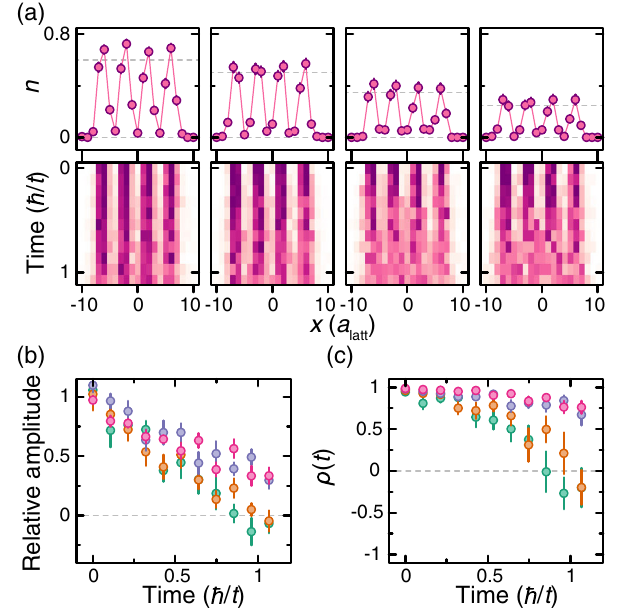
FIG. 5. Density dependence of quench dynamics. (a) (Top) initial state density profiles; (bottom) corresponding time evolu- tion of each initial state for V=t ¼ 2 . 9 ð 2 Þ . Color bar is the same as Fig. 4(a) with limits set by dotted lines on top panel. (b) Fitted relative amplitude of density profiles vs time. Colors (green, orange, purple, and pink) correspond to the initial states in (a) from low to high density. (c) Autocorrelation function of the density pattern. Colors are the same as in (b). Experimental error bars correspond to the standard error of the mean.